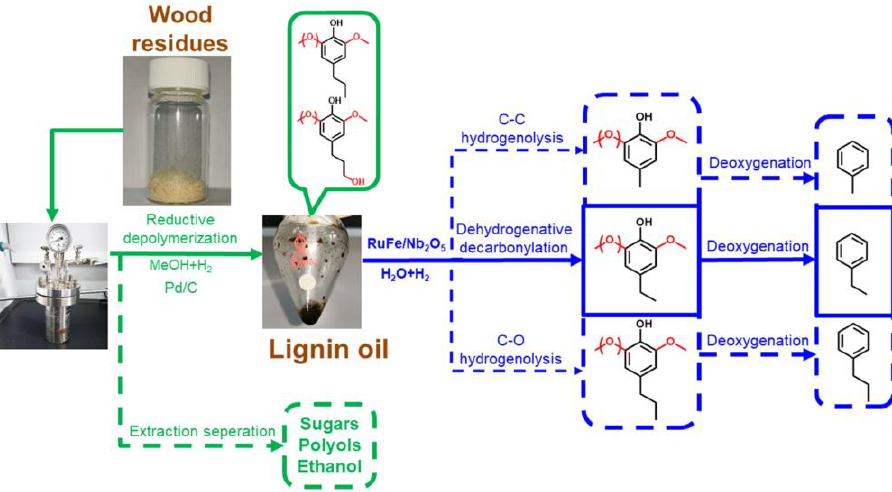
Figure 5. Procedure for the production of ethylbenzene from the lignin fraction of wood residues [25].